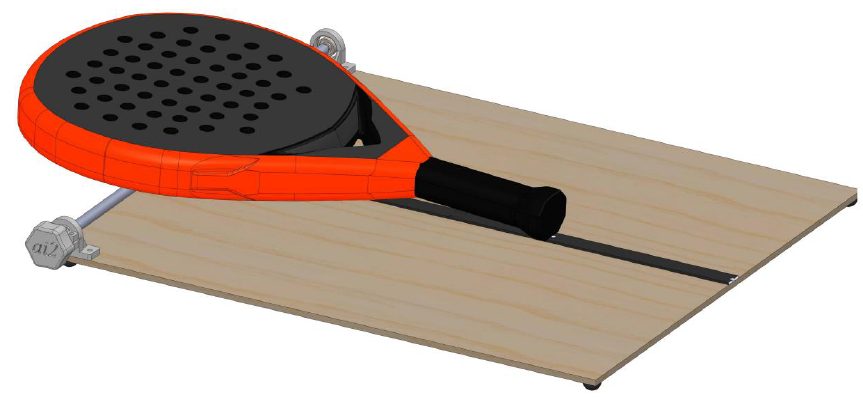
Figure 2. The device used to determine the COM of padel rackets.